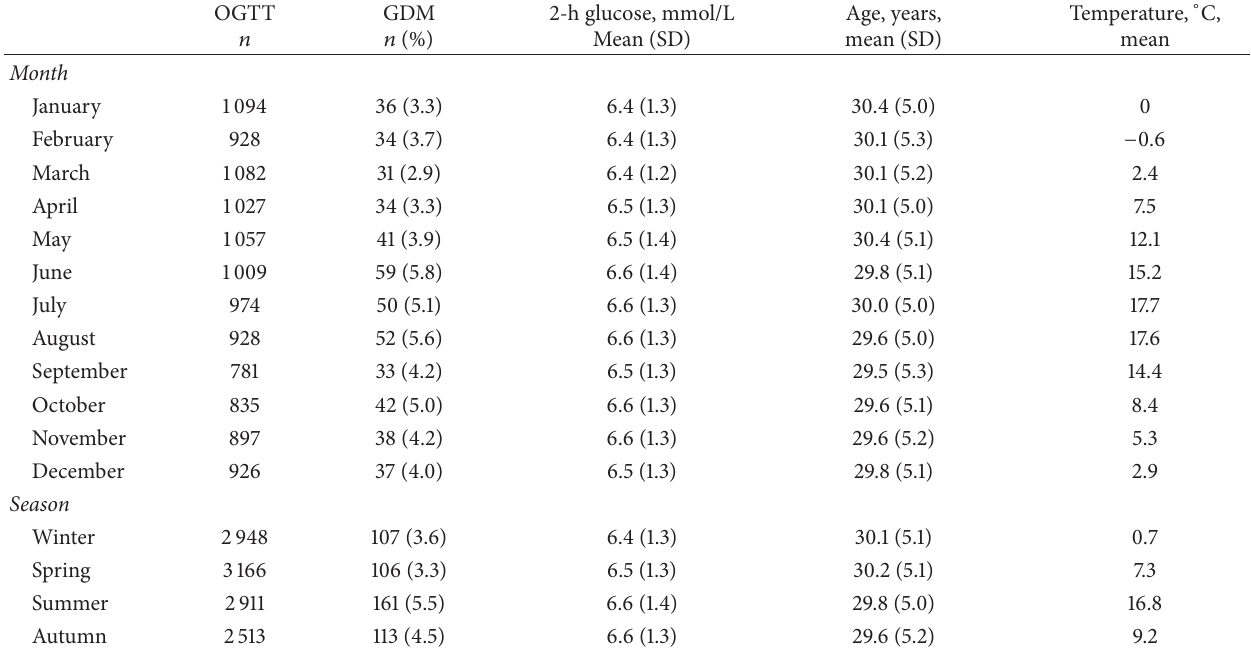
Table 1: Description of the study material, organized by month and season.